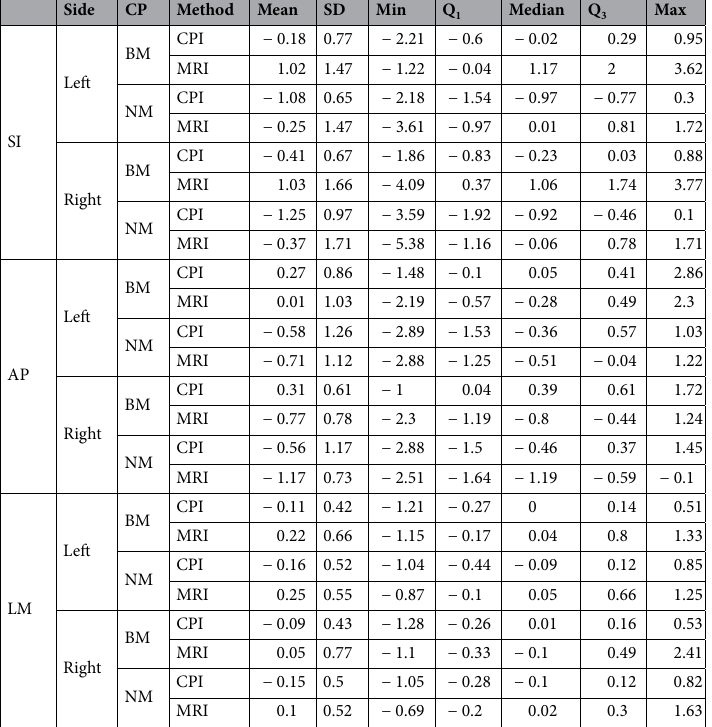
Table 1. Descriptive statistics for left and right x, y, and z coordinates of bimanually manipulated (BM) and neuromuscular (NM) condyle positions in millimeters for condylar position indicator (CPI) and